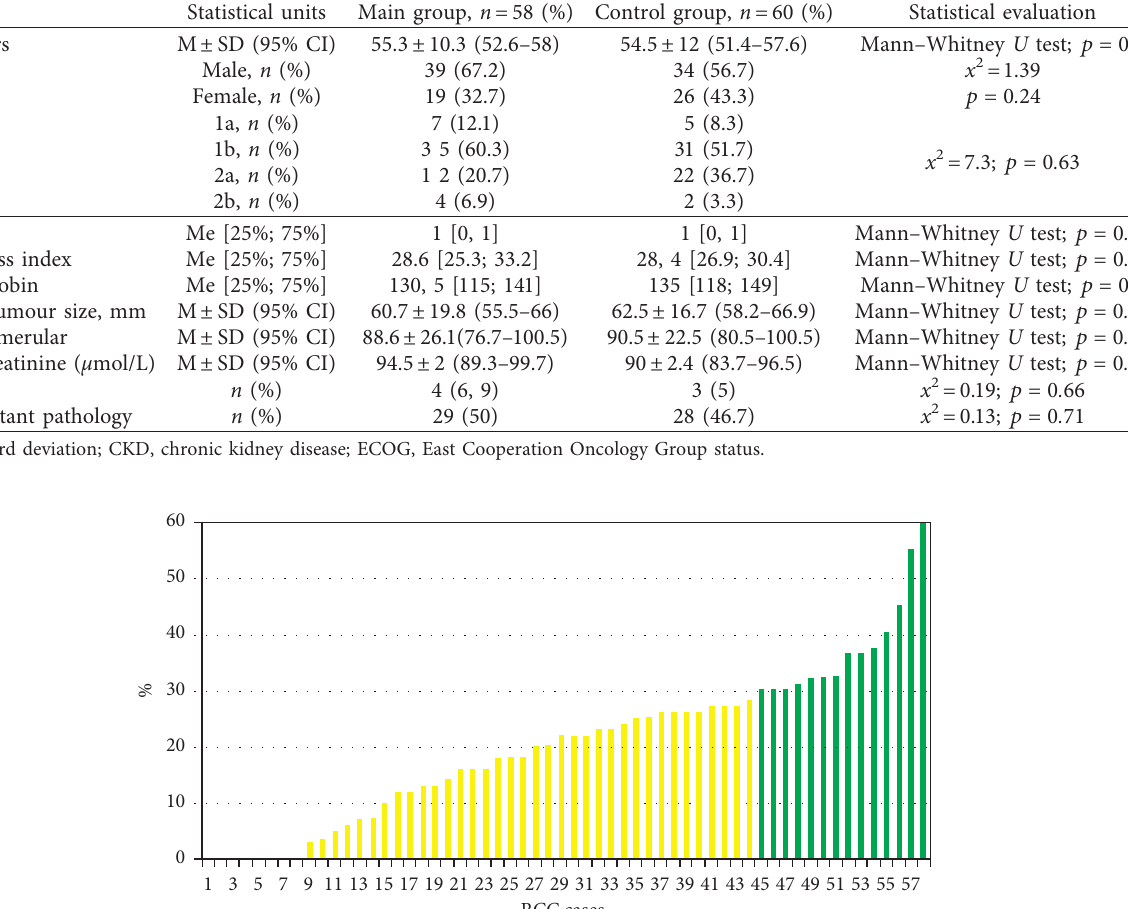
Table 1: Baseline patients characteristics, tumour stage and size, kidney function, and concomitant pathology, n � 118.